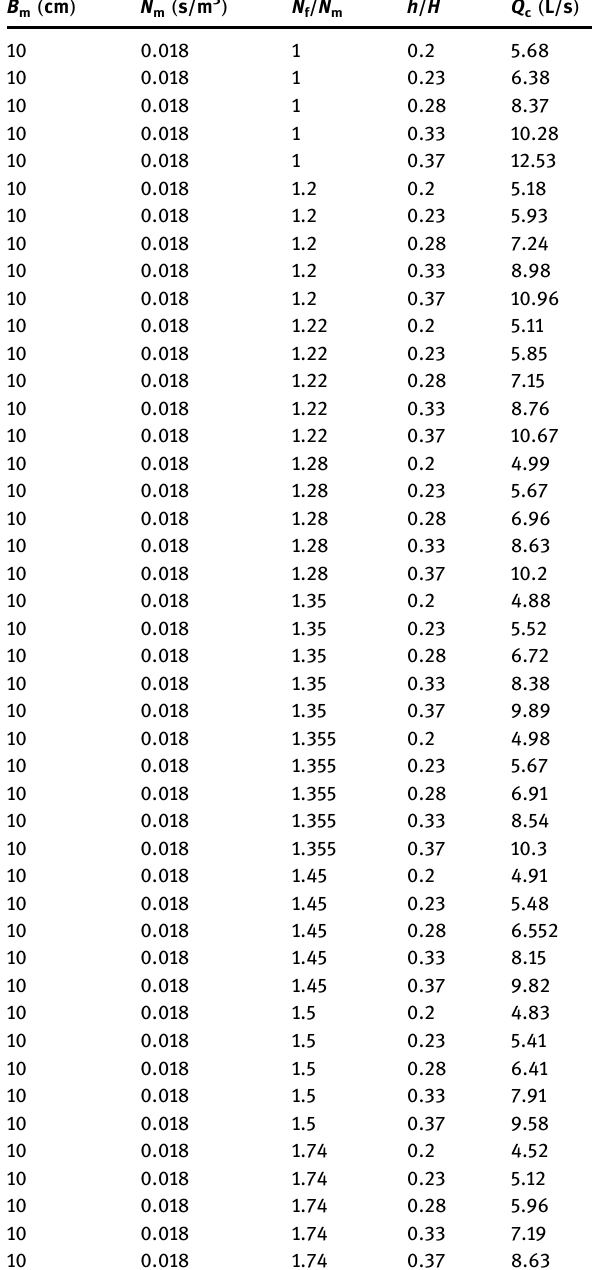
Table 1: Experimental data using ANFIS input